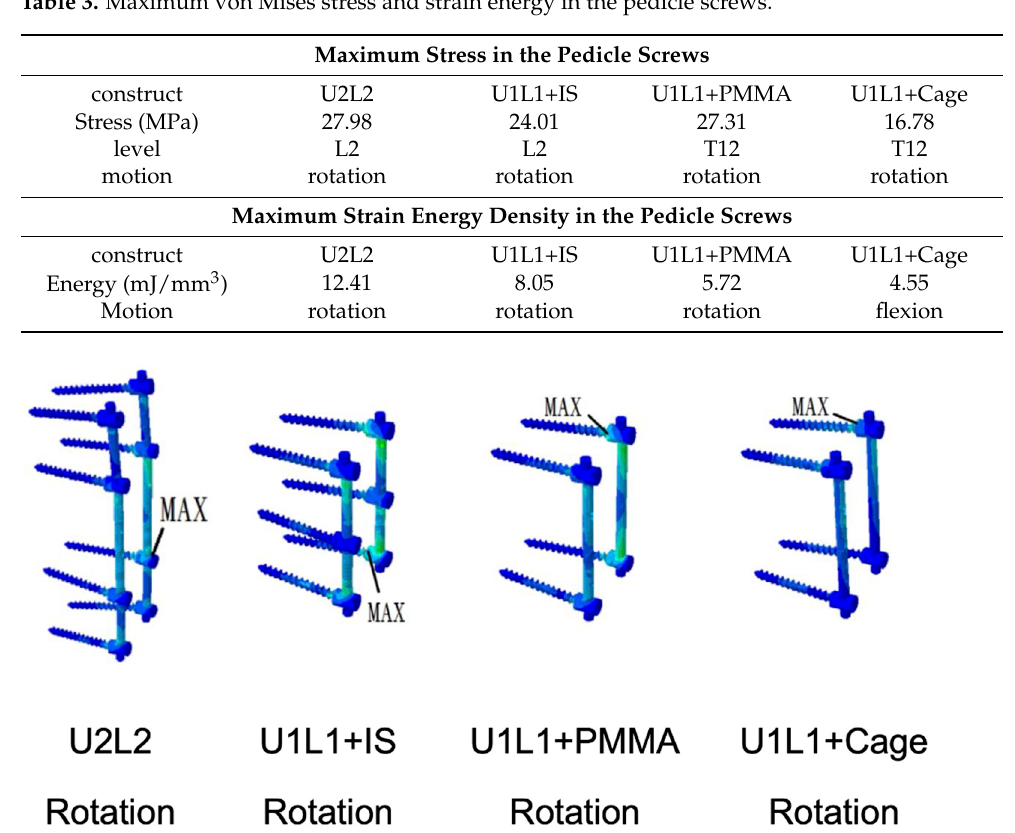
Figure 7. The stress distributions of the pedicle screw and rod constructs in the motions of maximum von Mises stress detected.